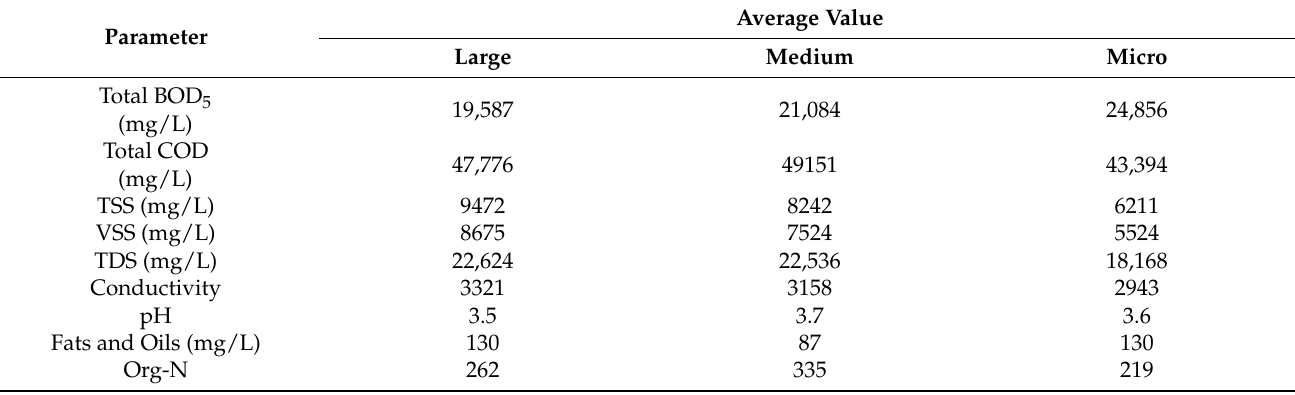
Table 3. Characterization of Tequila vinasse by factory size (3 L, 6 M, 15